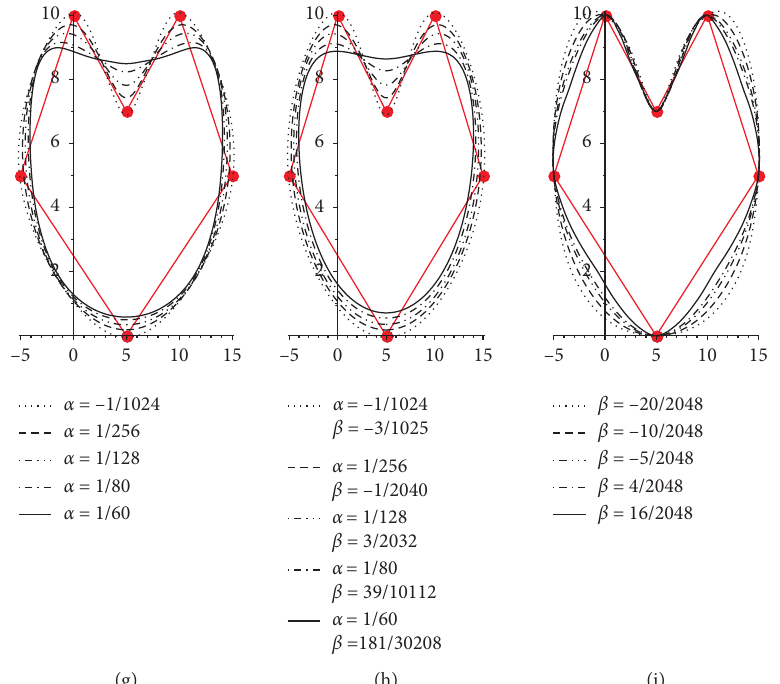
S S S S S ; (g) S a ; (h) S a ; a 2 ; (b) a 3 ; (c) a I 4 ; (d) a 4 ; (e) a 5 ; (f) a I 6 7 6